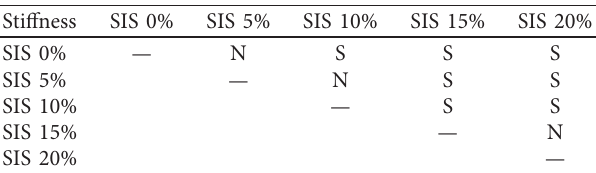
Figure 11: m-value of SIS binders at − 24 ° Table 5: Statistical analysis results of the stiffness value as a function of SIS content.